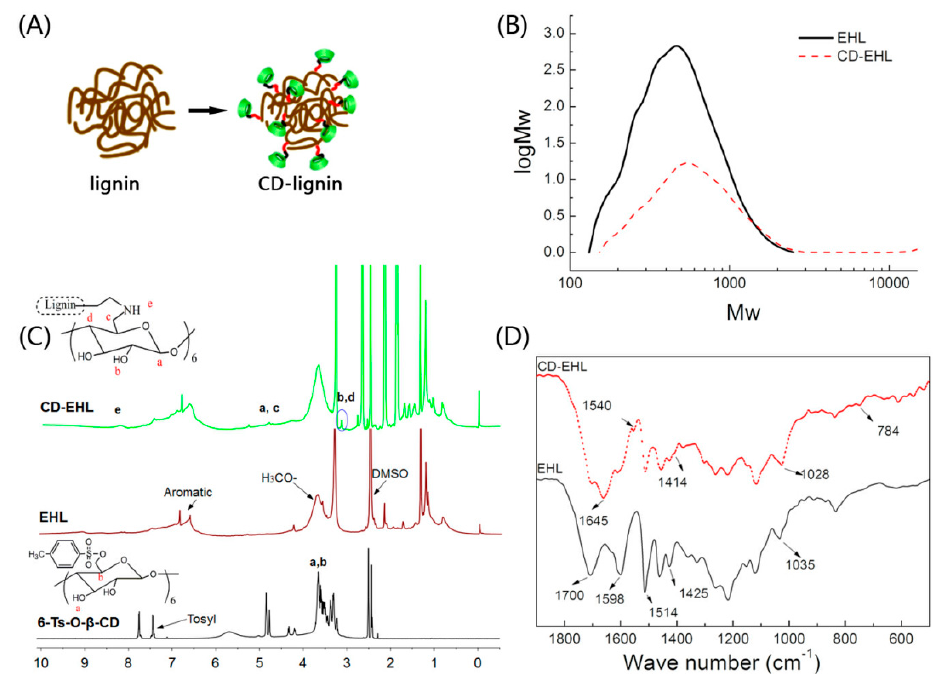
Figure 1. Preparation and characterization of cyclodextrin-(CD) enzymatic-hydrolysis lignin (EHL) (CD-EHL): ( A ) Schematic diagram of β -CD conjugated with EHL; ( B ) molecular weight distribution of EHL and CD-EHL; ( C ) 1H-NMR spectra of 6-TsO- β -CD, EHL and CD-EHL; ( D ) infrared spectrograms of EHL and CD-EHL.